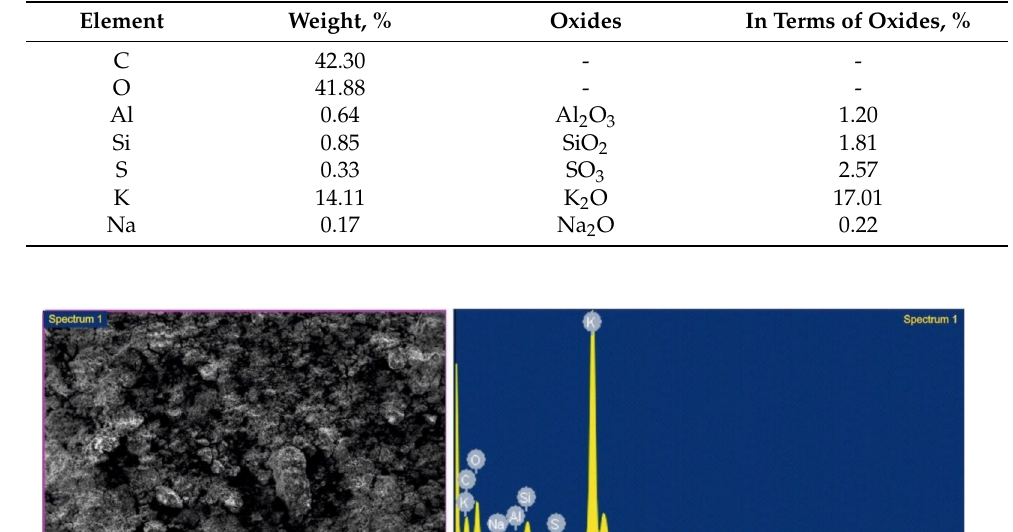
Table 7. Element-weight composition of production potassium humate.